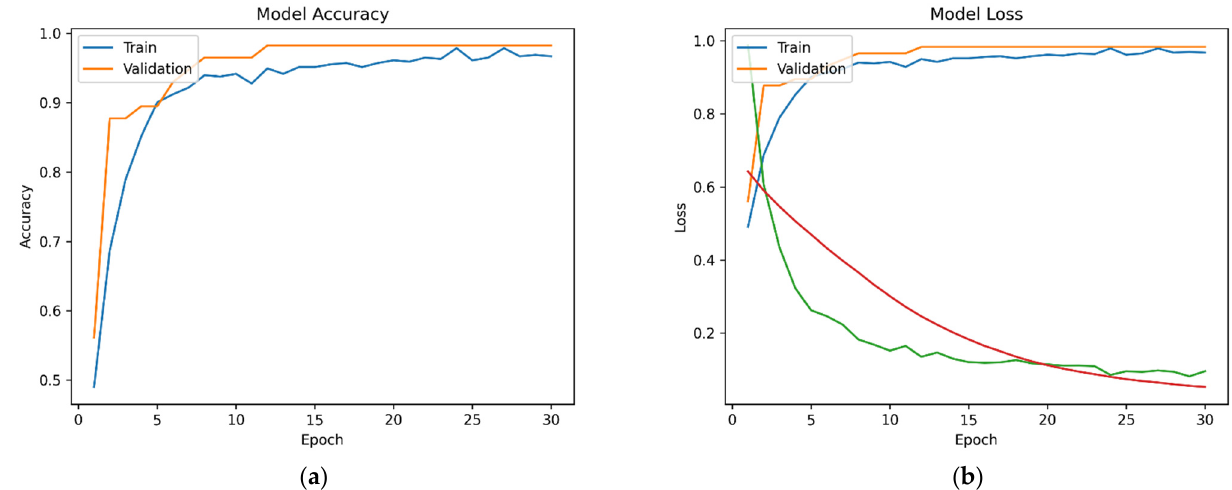
Figure 5. Illustration of model training results: ( a ) model accuracy, and ( b ) model loss. The Precision and Recall Curve and Receiver Operating Characteristic (ROC) are presented in Figure 6. The show that the best ANN model has achieved the mean precision of 0.99 and the AUC of 1.00.